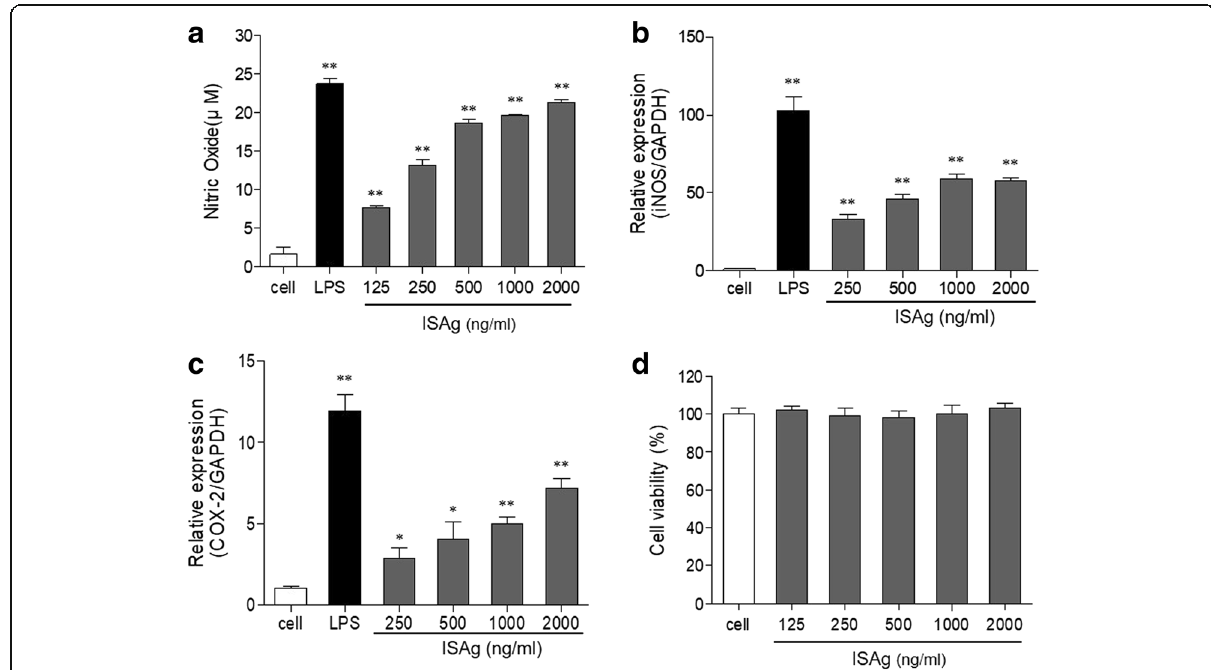
Fig. 1 ISAg induced NO production and COX-2 gene expression in murine peritoneal macrophages. a RAW264.7 cells were treated with LPS (1 μ g/mL) or indicated concentrations of ISAg for 24 h. The amount of NO production was then measured using Griess reagents and an ELISA kit. Gene expression levels of ( b ) iNOS and ( c ) COX-2 relative to GAPDH were analyzed using qRT-PCR. d In all experiments, no significant toxic effects of ISAg were detected in the cells. The mean ± standard deviation values are presented ( n = 3 per group; Student ’ s t-test; * P < 0.05, ** P <